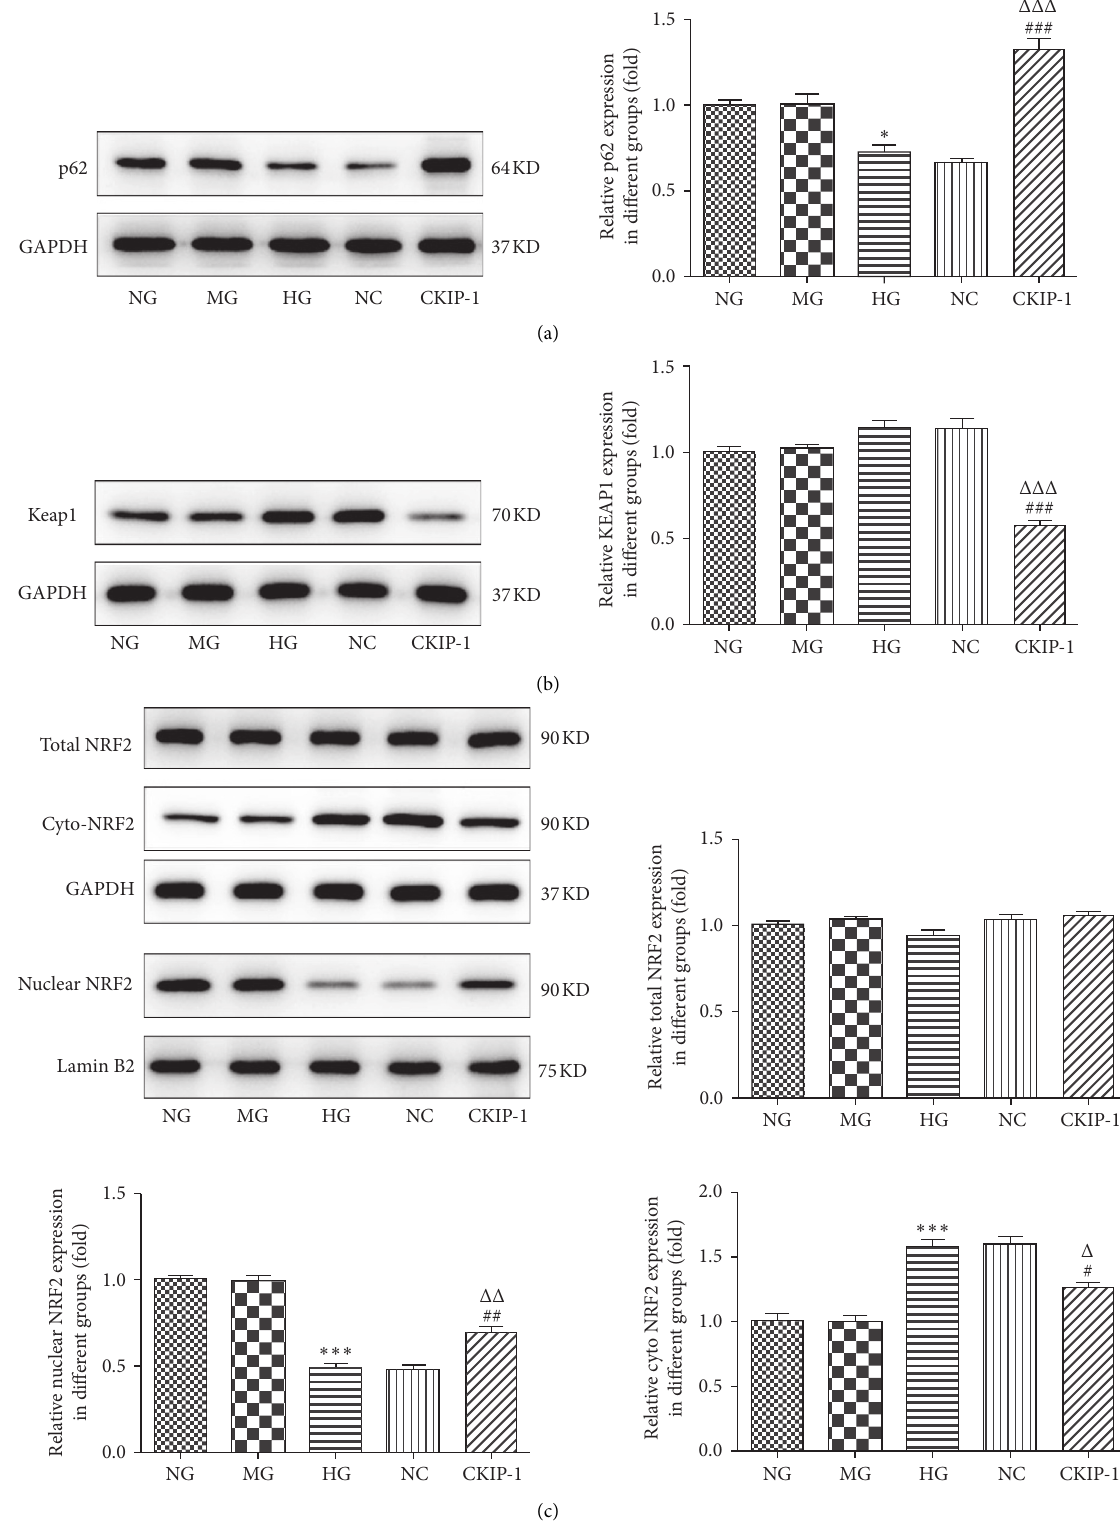
Figure 3: CKIP-1 activated the p62/Keap1/Nrf2 signaling pathway. (a) p62 expression was determined by Western blot in different groups. (b) Keap1 expression was determined by Western blot. (c) The expression of Nrf2 in whole cells or in the nucleus and cytosol. Lamin B2 and GAPDH were performed as the loading control of nuclear, whole cells, and cytoplasm, respectively. ∗ p < 0.05 and ∗∗∗ p < 0.001 vs. NG. # p < 0.05, ## p < 0.01, and ### p < 0.001 vs. HG. Δ p < 0.05, ΔΔ p < 0.01, and ΔΔΔ p < 0.001 vs. NC. NG, normal glucose (5.5mM); MG, mannitol (20mM); HG, high glucose (25mM); NC, pcDNA3.1 vector negative control; CKIP-1,